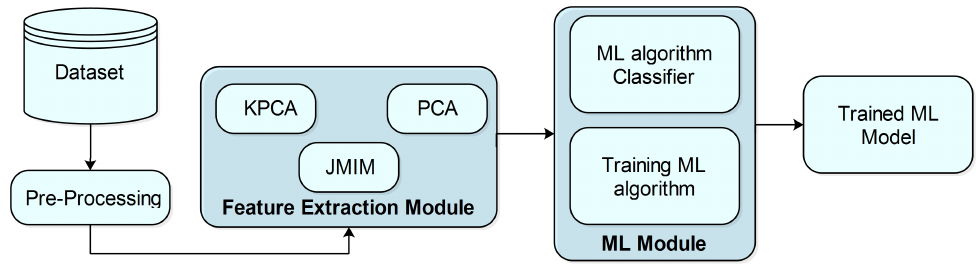
Figure 7. General Machine learning framework adopted in smart